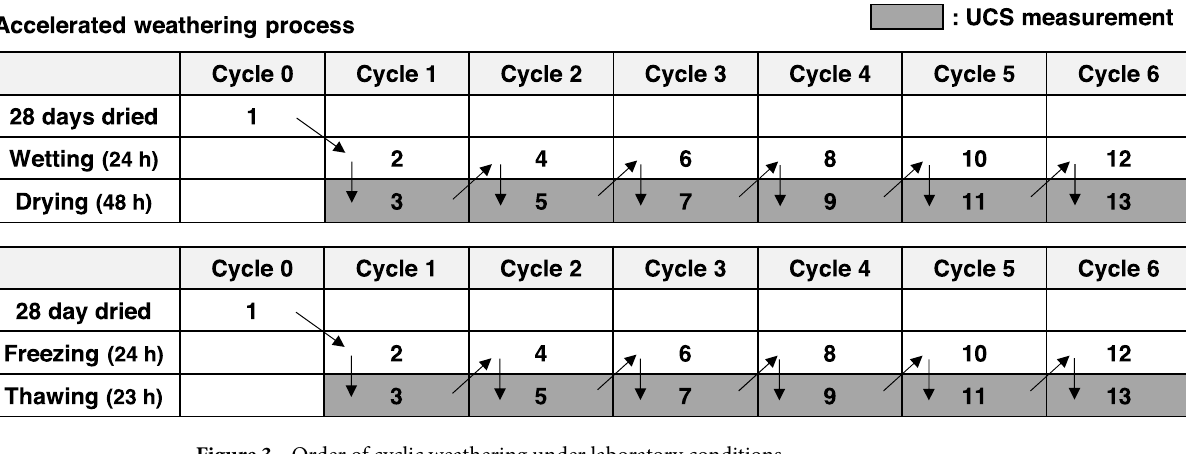
Figure 3. Order of cyclic weathering under laboratory conditions.